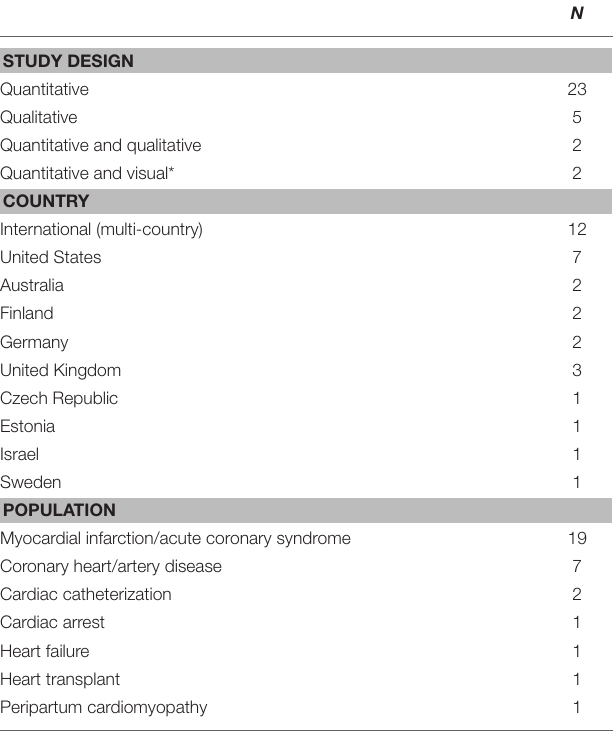
Frontiers in Psychology |